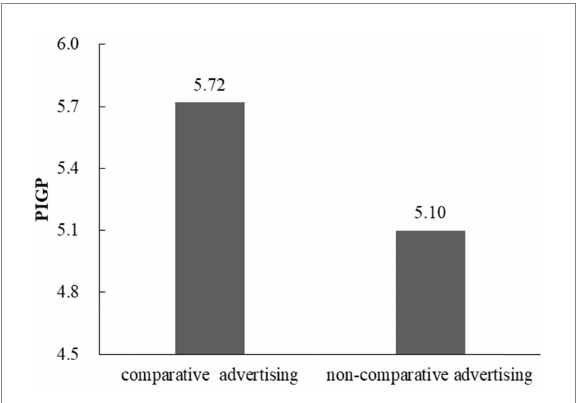
FIGURE 2 PIGP for comparative advertising and non-comparative